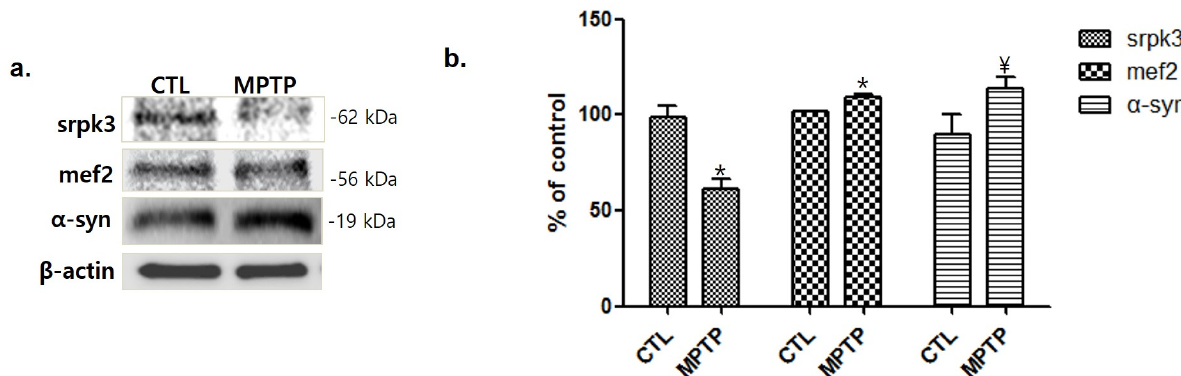
Figure 3. Decrease in serine/arginine-rich protein specific kinase 3 ( srpk3 ) expression in the quadriceps femoris of an MPTP-induced parkinsonism mouse model. ( a ) The results of the Western blot are shown. ( b ) Histograms of the Western blot analyses showing decreased srpk3 expression and increased mef2 and α -synuclein expression in the MPTP group compared to the CTL group, in which the expression was normalized to 100% ( n = 3). CTL, control (phosphate-buffered